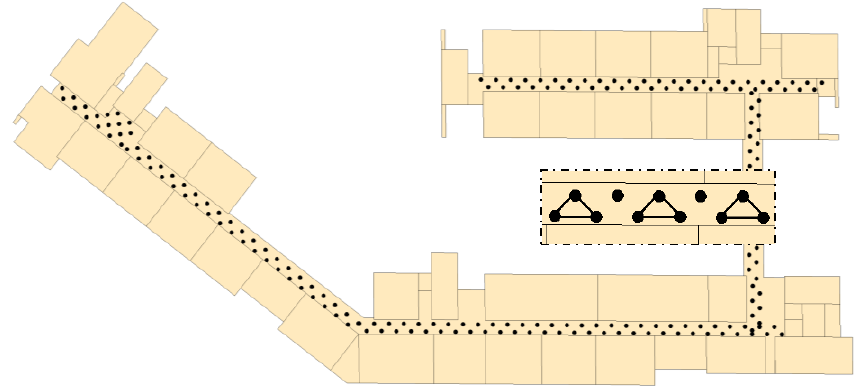
Figure 10. Triangular mesh structure layout of fingerprint points. Table 2. Positioning results based on different layout fingerprint databases.